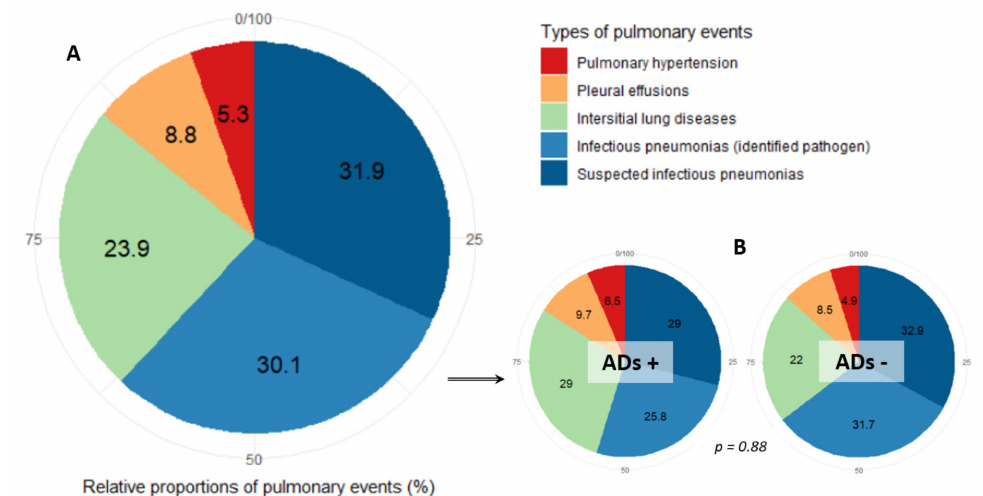
Figure 2. Pie charts of the different types of pulmonary events occurring in myelodysplastic patients. ( A ): Overall cohort. ( B ): myelodysplastic syndrome with associated autoimmune or auto-inflammatory diseases (ADs +) versus without (ADs −